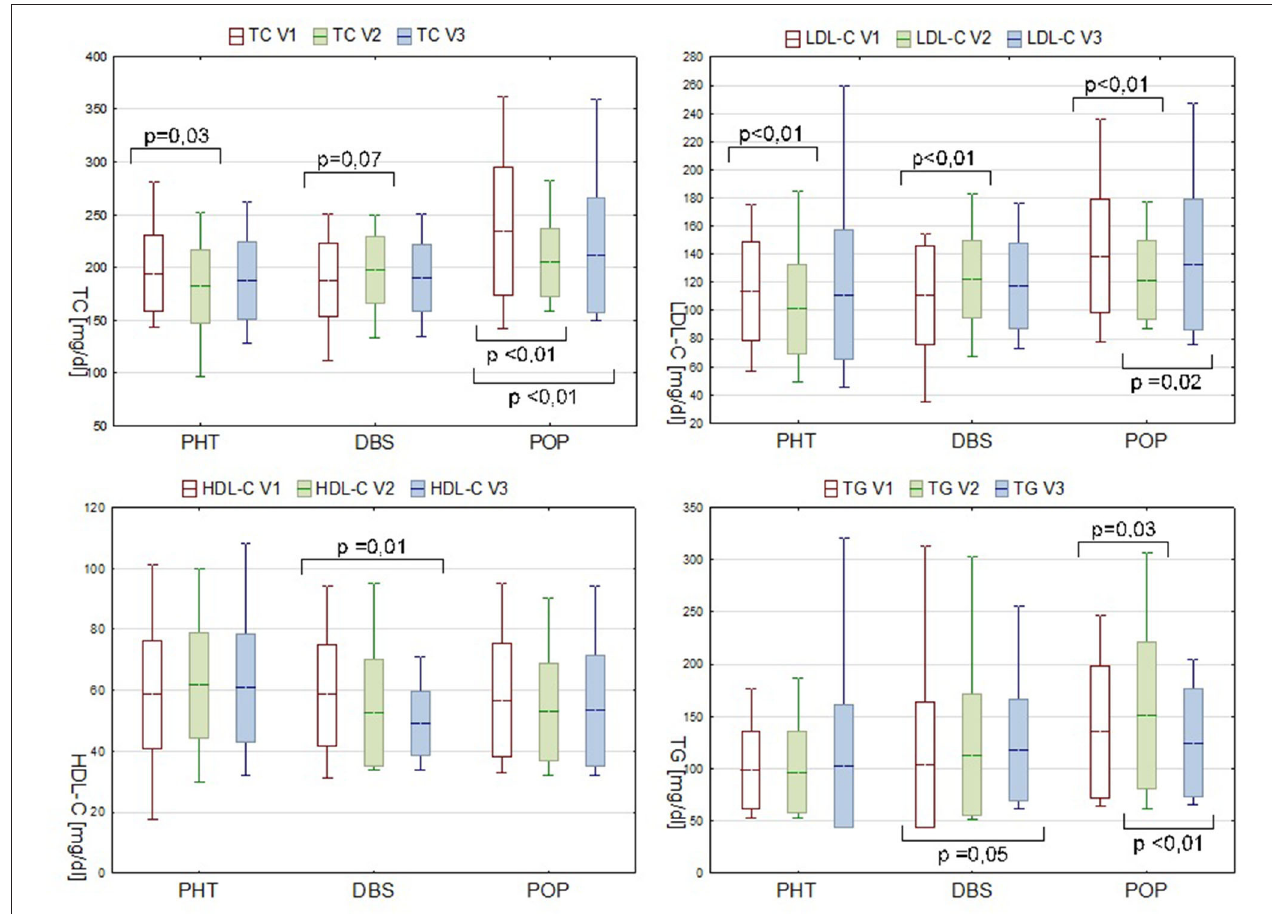
FIGURE 1 | Serum lipids levels in PHT, DBS, and POP groups during consecutive visits. Data are presented as mean ± SD and min—max